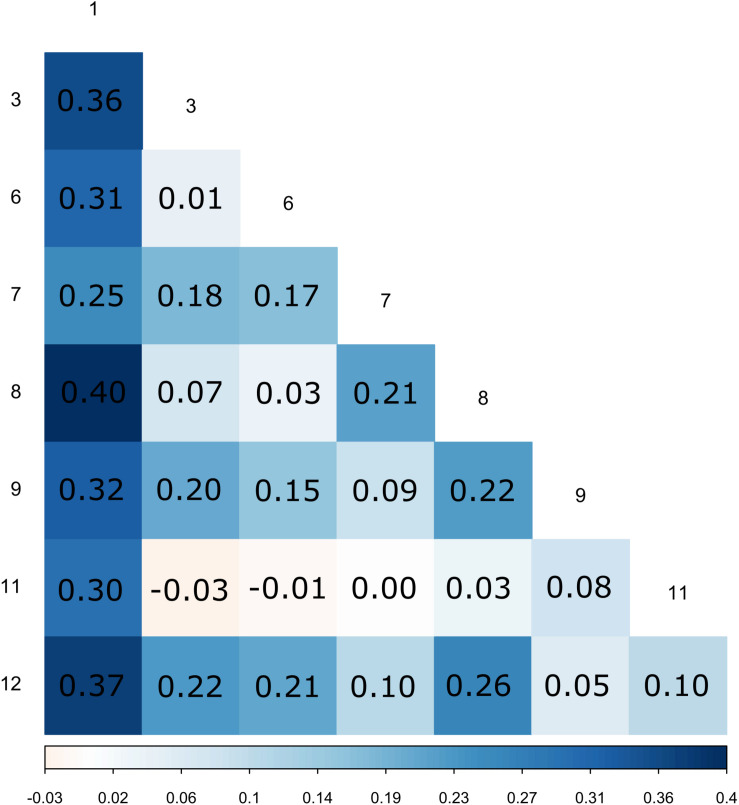
Pairwise FST between patches.